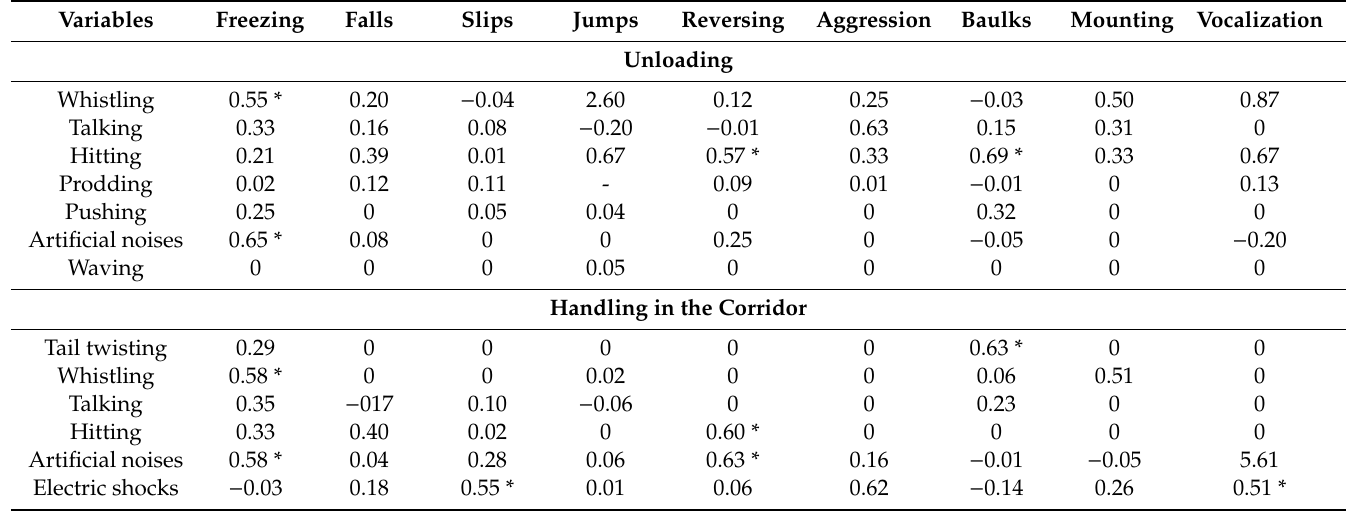
Table 4. Pearson correlation coe ffi cients (r) between the interactions of the handlers and behavioral events of dairy cull cows during handling at abattoir. Variables Freezing Falls Slips Jumps Reversing Aggression Baulks Mounting Vocalization Unloading Whistling 0.55 *